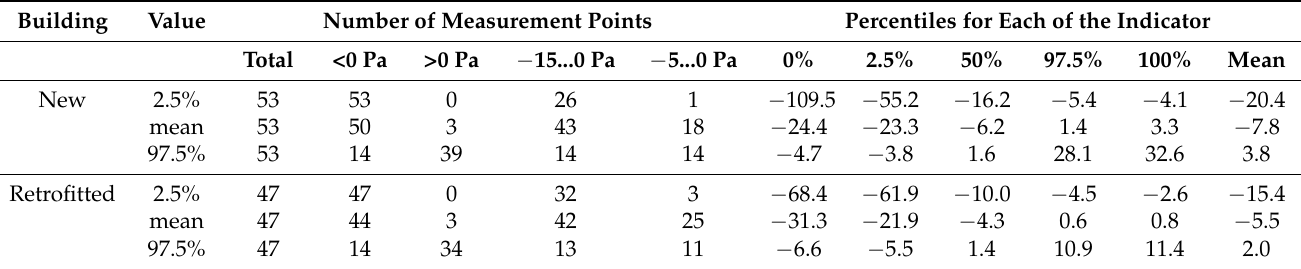
Table 2. The number of measurement points belonging to different groups and the cumulative distribution function percentiles for air pressure differences in the groups.